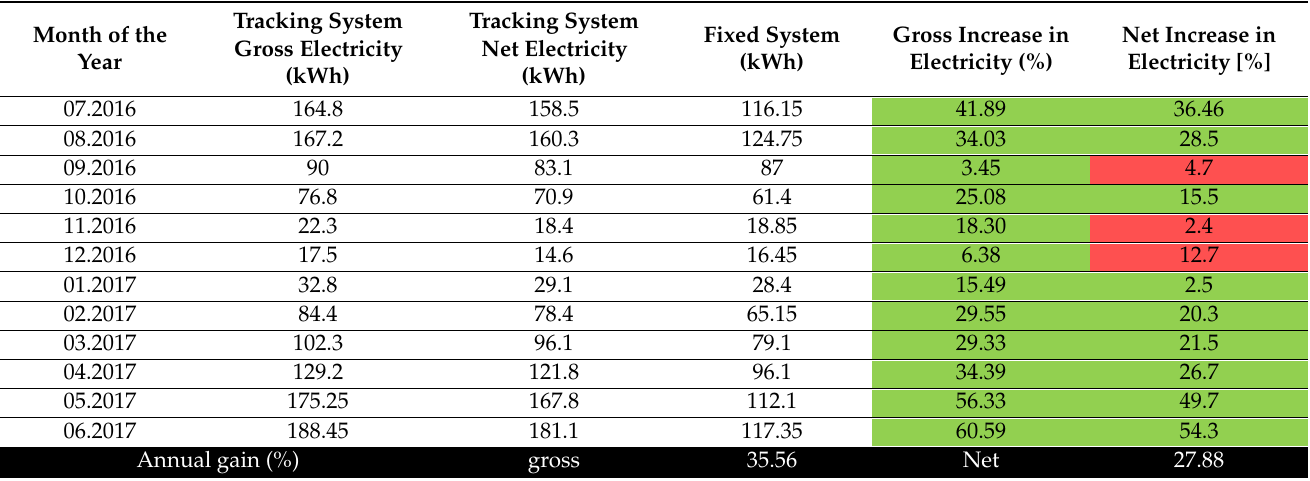
Table 6. Percentage gain and value of electricity produced by the dual-axis tracking system and fixed system in the period between 07.2016 and 06.2017. Month of the